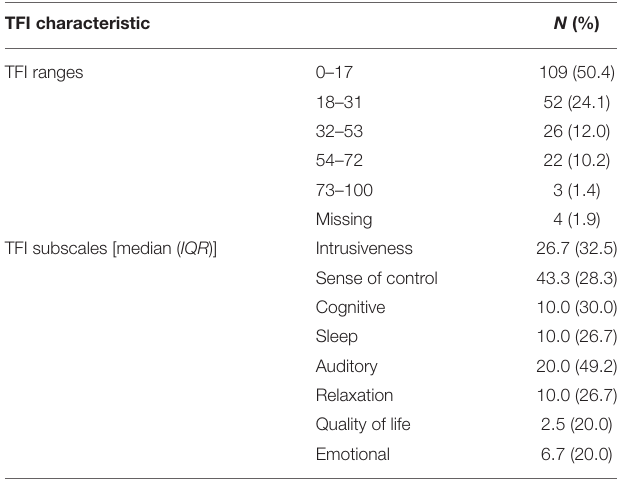
TABLE 4 | TFI characteristics of pathologic tinnitus participants ( N = 212, 4 missing). TFI